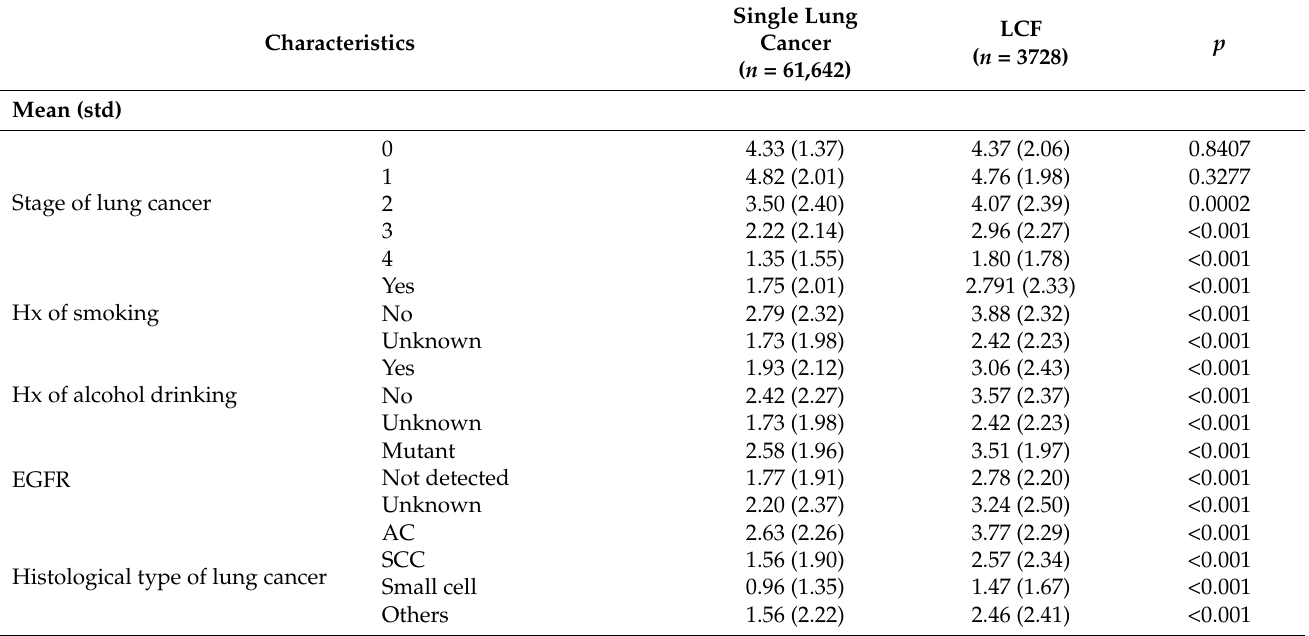
Table 3. Mean survival time in patients with single lung cancer and LCF.